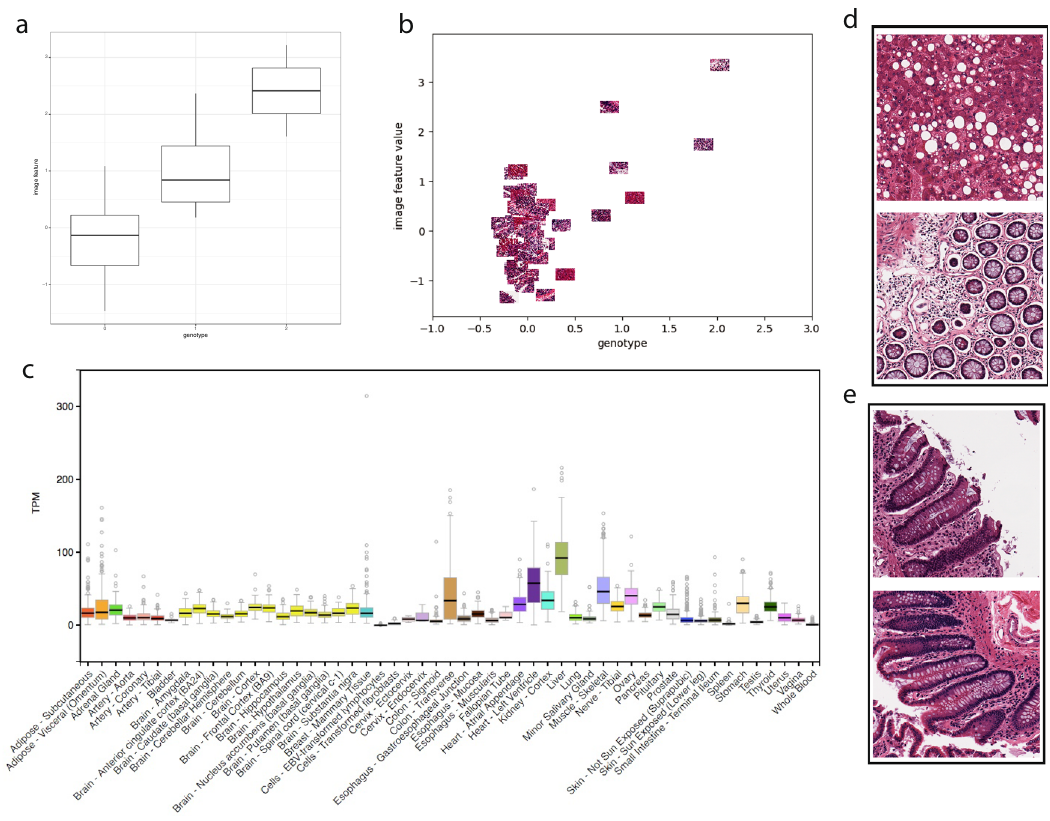
Fig. 5 Genotype and image feature association for an eQTL targeting lactate dehydrogenase D ( LDHD ) in colon samples. a Boxplot of association between genotype rs8059637 ( x -axis) and image feature 799 values for all samples ( y -axis), the box hinges are the fi rst quartile, the median, and third quartile of the image feature values, respectively, the lower whisker ranges from the bottom hinge to no less than 1.5*IQR (inter-quartile range), the upper whisker ranges from the top hinge to no more than 1.5*IQR; b same axes as ( a ), but points are the colon images with jitter added to separate the images; c relative abundance of LDHD expression across GTEx tissues, with colon — traverse showing substantial expression levels, boxplot de fi ned the same as ( a ) with outlier points de fi ned as greater than or less than the whisker range; d images in the top 10% of values for image feature 799; e images in the bottom 10% of values for image feature